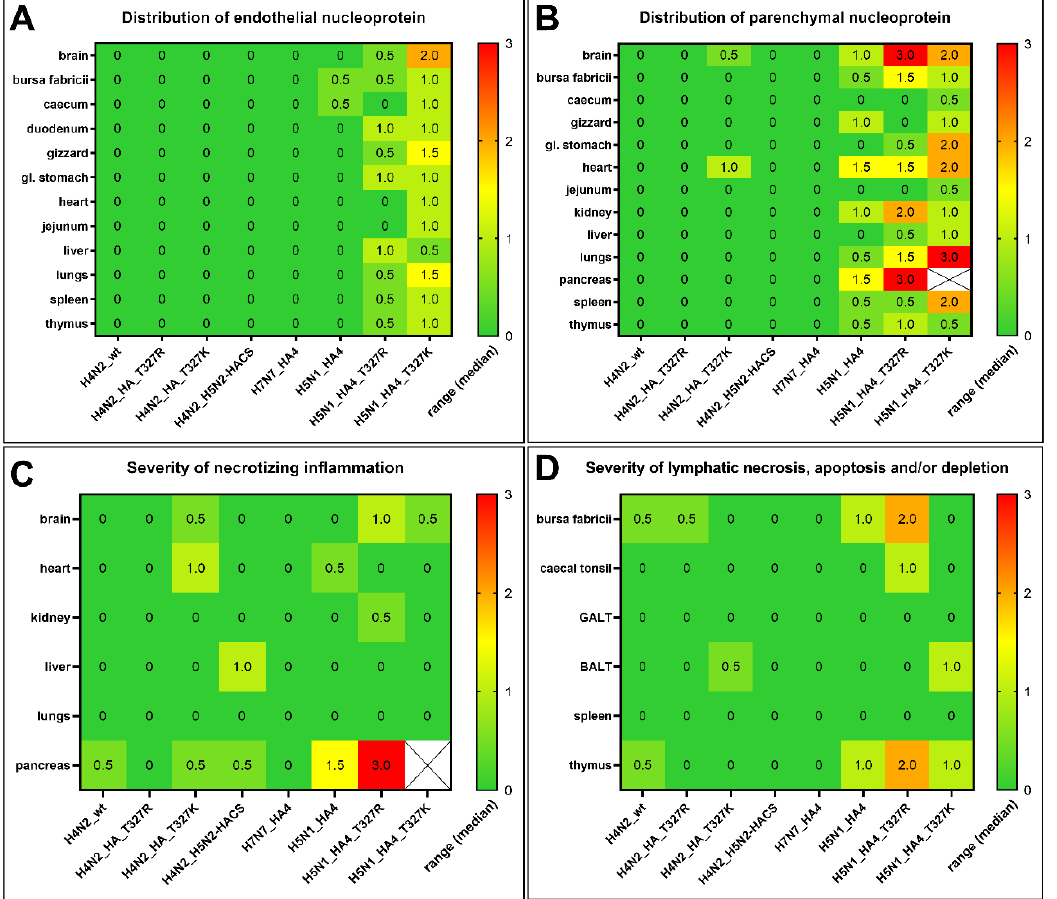
Figure 6. Distribution of avian influenza virus NP in organs of inoculated birds and severity of lesions. Distribution of NP antigen in endothelial ( A ) and parenchymal ( B ) cells as well as the severity of necrotizing inflammation ( C ) and lymphatic depletion ( D ) in the affected organs of inoculated birds scored from 0 to 3.0 (green to red color). Results are shown as the median score of two birds. Samples were collected at 4 dpi for all chickens, except H5N1_H4_T 327 K inoculated birds, which died at 2 dpi and were kept in the refrigerator until 4 dpi. Pancreas samples with white cells and an X symbol in panels B and C were not tested because of insufficient quality for evaluation.